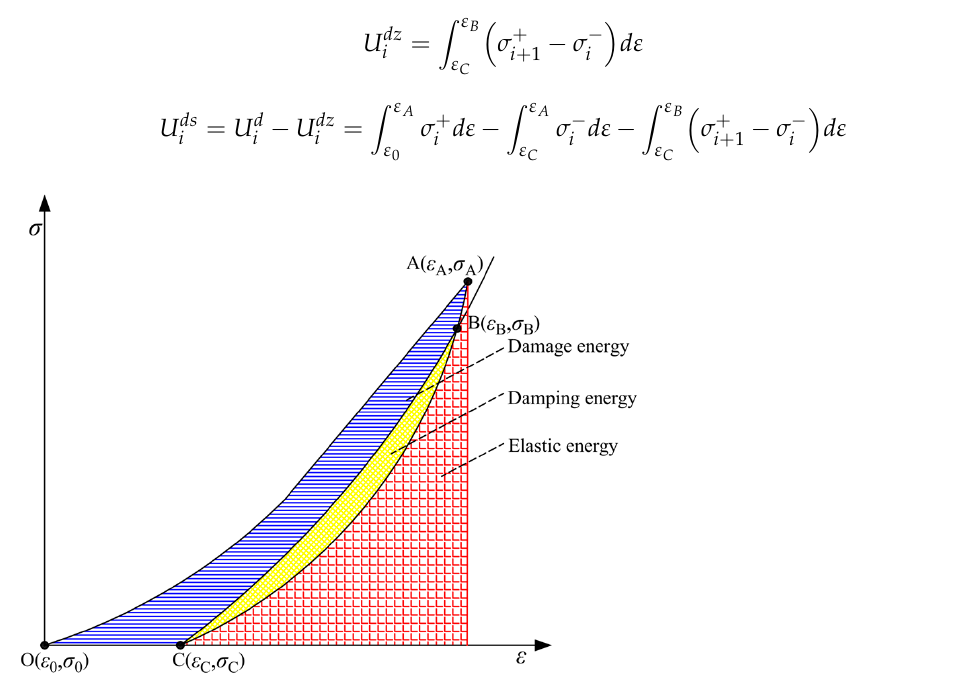
Figure 12. Diagram of energy